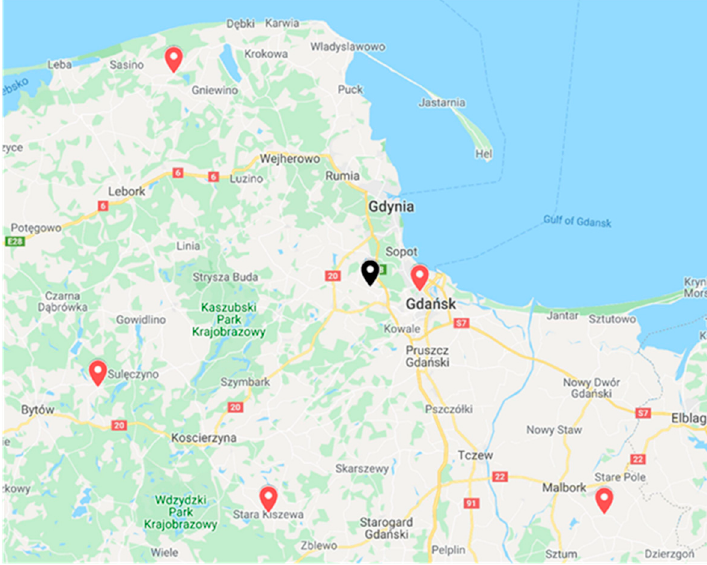
Figure 3. Map with marked locations of radio stations (RS) (map background from Google Maps).